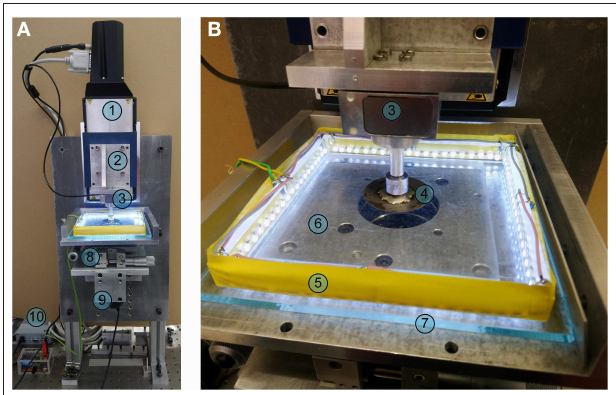
FIGURE 1 | Experimental device: (A) general view; (B) contact zone between the steel indenter and 5mm thick transparent rubber layer placed on the glass